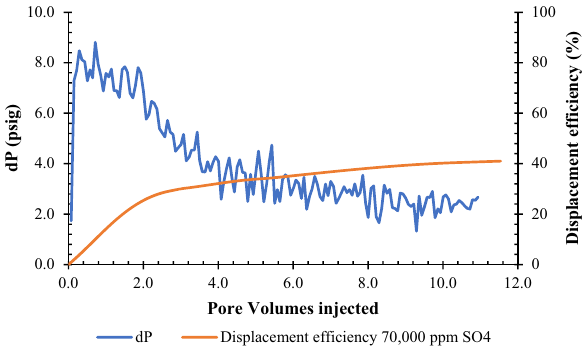
Fig. 6 Oil droplet for IFT measurement showing dimension